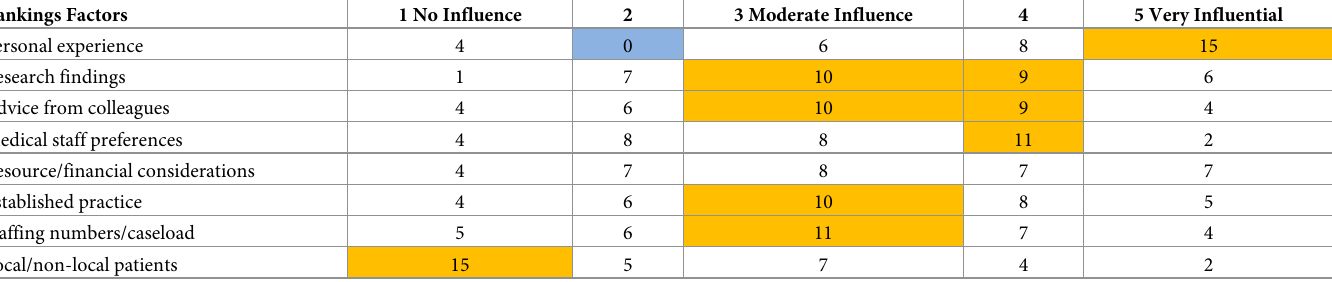
Table 5. Rankings awarded by respondents for the influence of selected factors on respondents’ physiotherapy practice with respect to passive limb range of